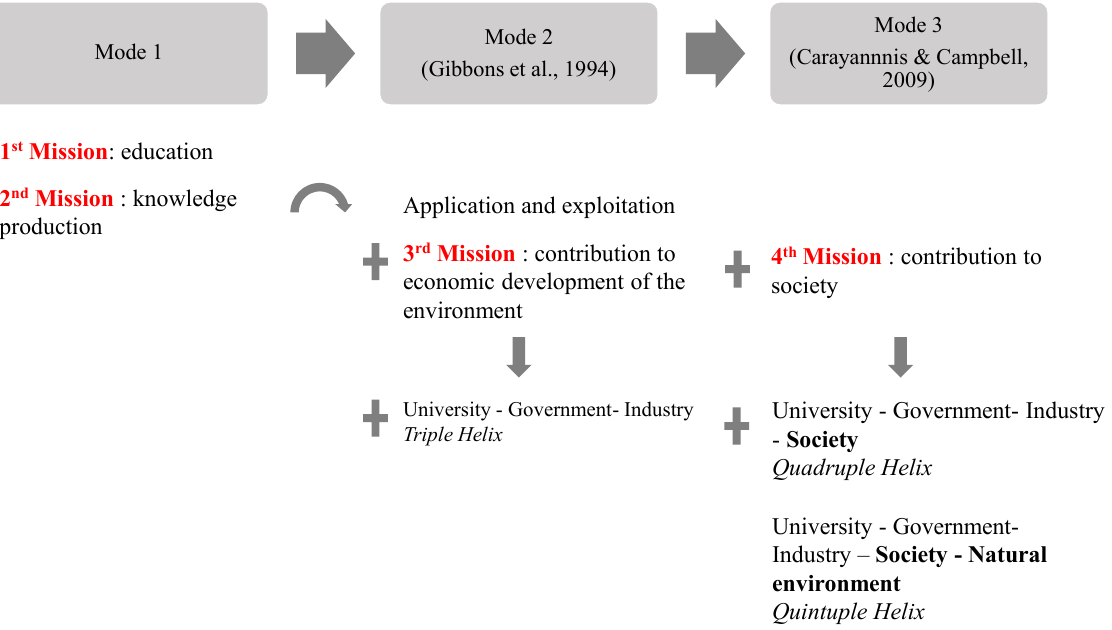
Fig. 1. Evolution of the cardinal functions of the university. SOURCE: developed by the authors based on Fernández et al.